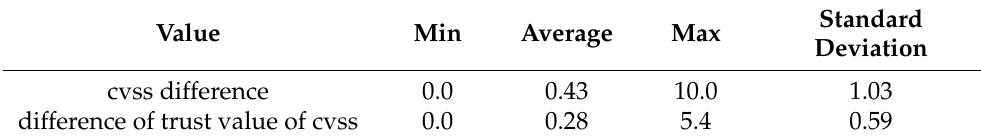
Table 8. Analysis of dispersion of CVSSv2 (risk assessment) and trust value related to CVSS.